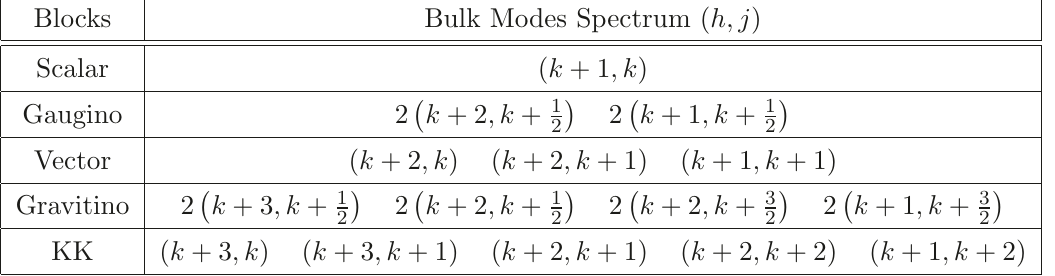
Table 2 . Mass spectrum of bulk modes in non-BPS blocks. The label k = 0 , 1 , . . . . Boundary modes in gravitino